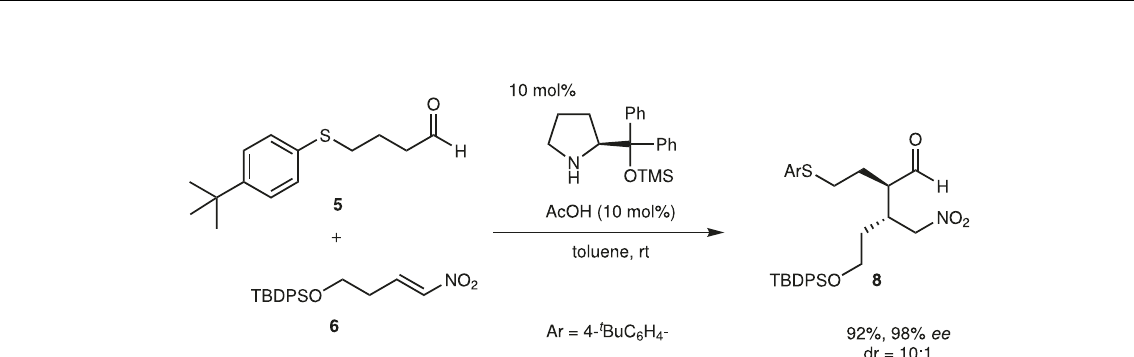
Fig. 3 | Diphenylprolinol sily ether-mediated asymmetric Michael reaction. Asymmetric Michael reaction of 5 and 6 using diphenylprolinol silyl ether. Enantiomeric excess (ee) was determined after Wittig reaction. t Bu t